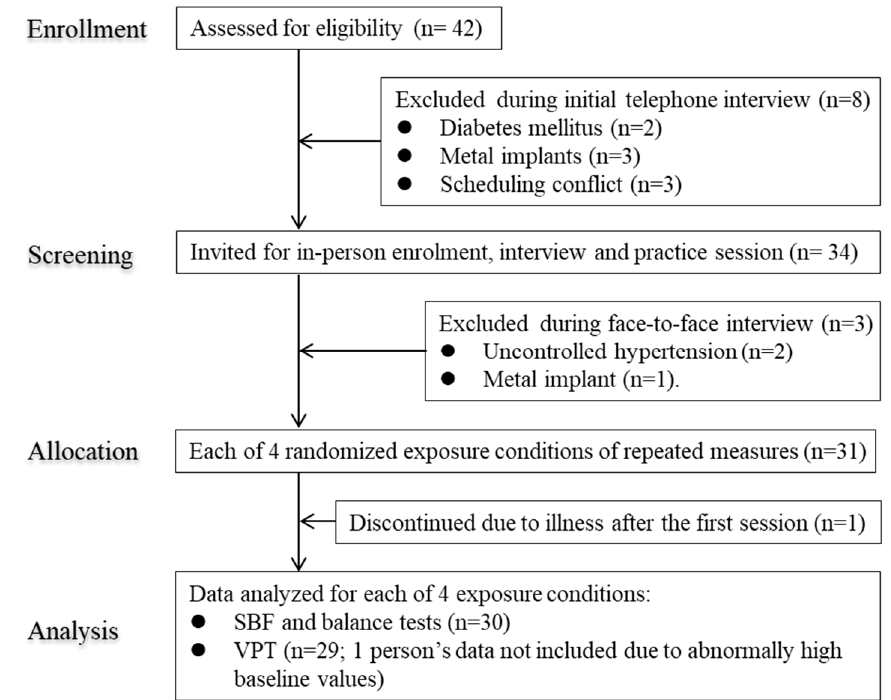
Figure 1. Flow diagram of participants included in this study.